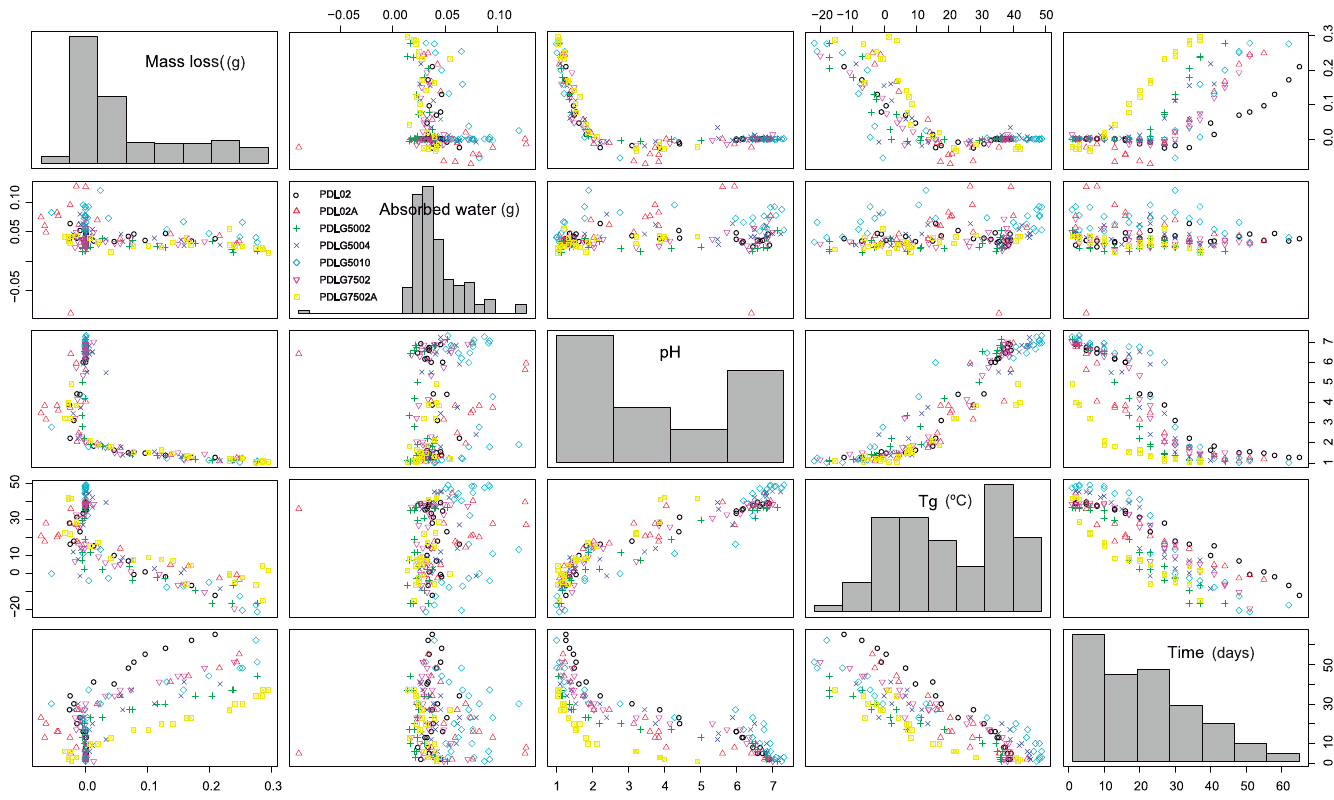
Fig 5. Descriptive analysis of the dependency structure between